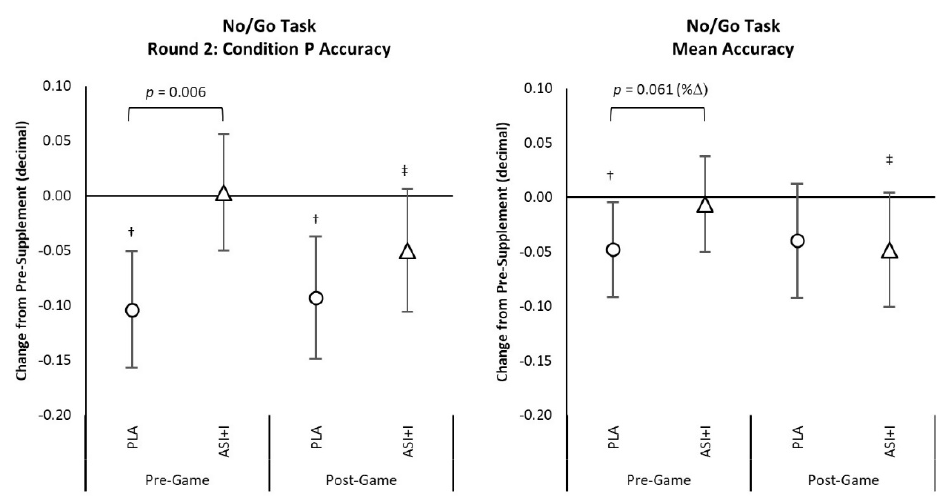
Figure 3. Mean changes from baseline in selected No/Go Task data. † represents p < 0.05 change from baseline values. ‡ represents p > 0.05 to p < 0.10 difference from baseline values.